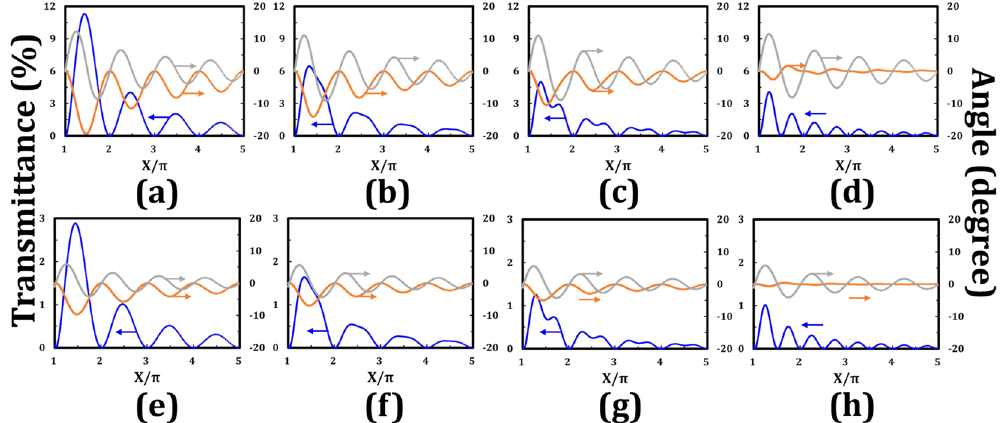
Figure 3. Theoretical minimum transmittance (blue) of the output beam through a tandem-2 φ -TNLC cell and an analyzer with its transmissive axis perpendicular to the major-axis of the output polarized light, χ angle (orange), and Δφ error angle (gray) of the output polarized beam through a tandem-2 φ -TNLC cell versus the X/ π values at different β angles with φ of ( a – d ) 45° and ( e – h ) 22.5°, as calculated by Jones Calculus. ( a , e ), ( b , f ), ( c , g ) and ( d , h ) figures represent the different β angles of 0°, 22.5°, 30°, and 45°, respectively. The titles of the primary and the secondary vertical axes for the eight figures are transmittance (%) and angle (degree),